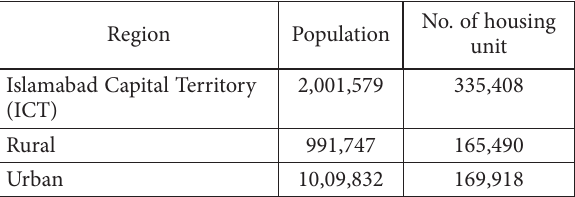
Table 4. Population of Islamabad